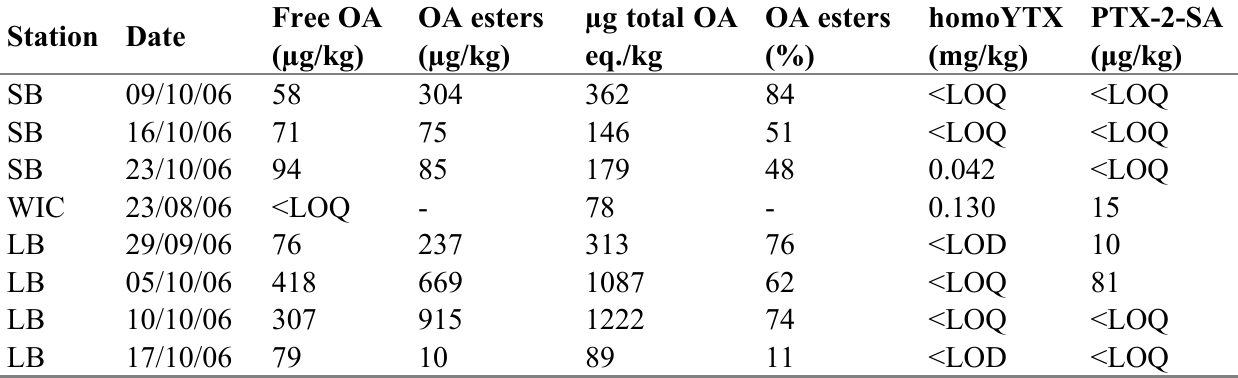
Table 2. Lipophilic toxins levels determined in DSP positive mussel